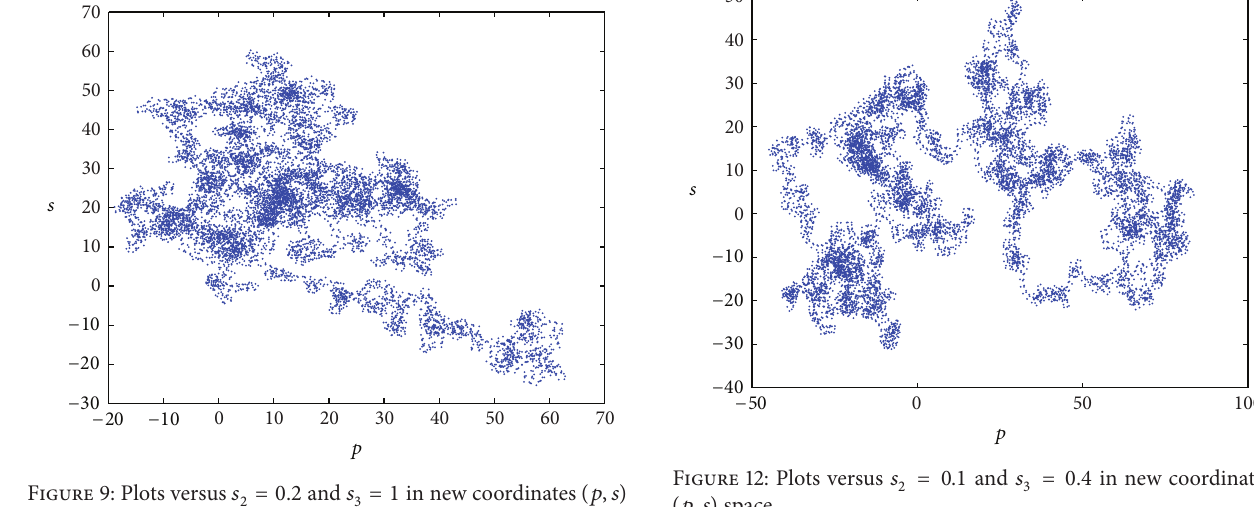
Figure 9: Plots versus 𝑠 2 = 0.2 and 𝑠 3 = 1 in new coordinates (𝑝,𝑠) space.